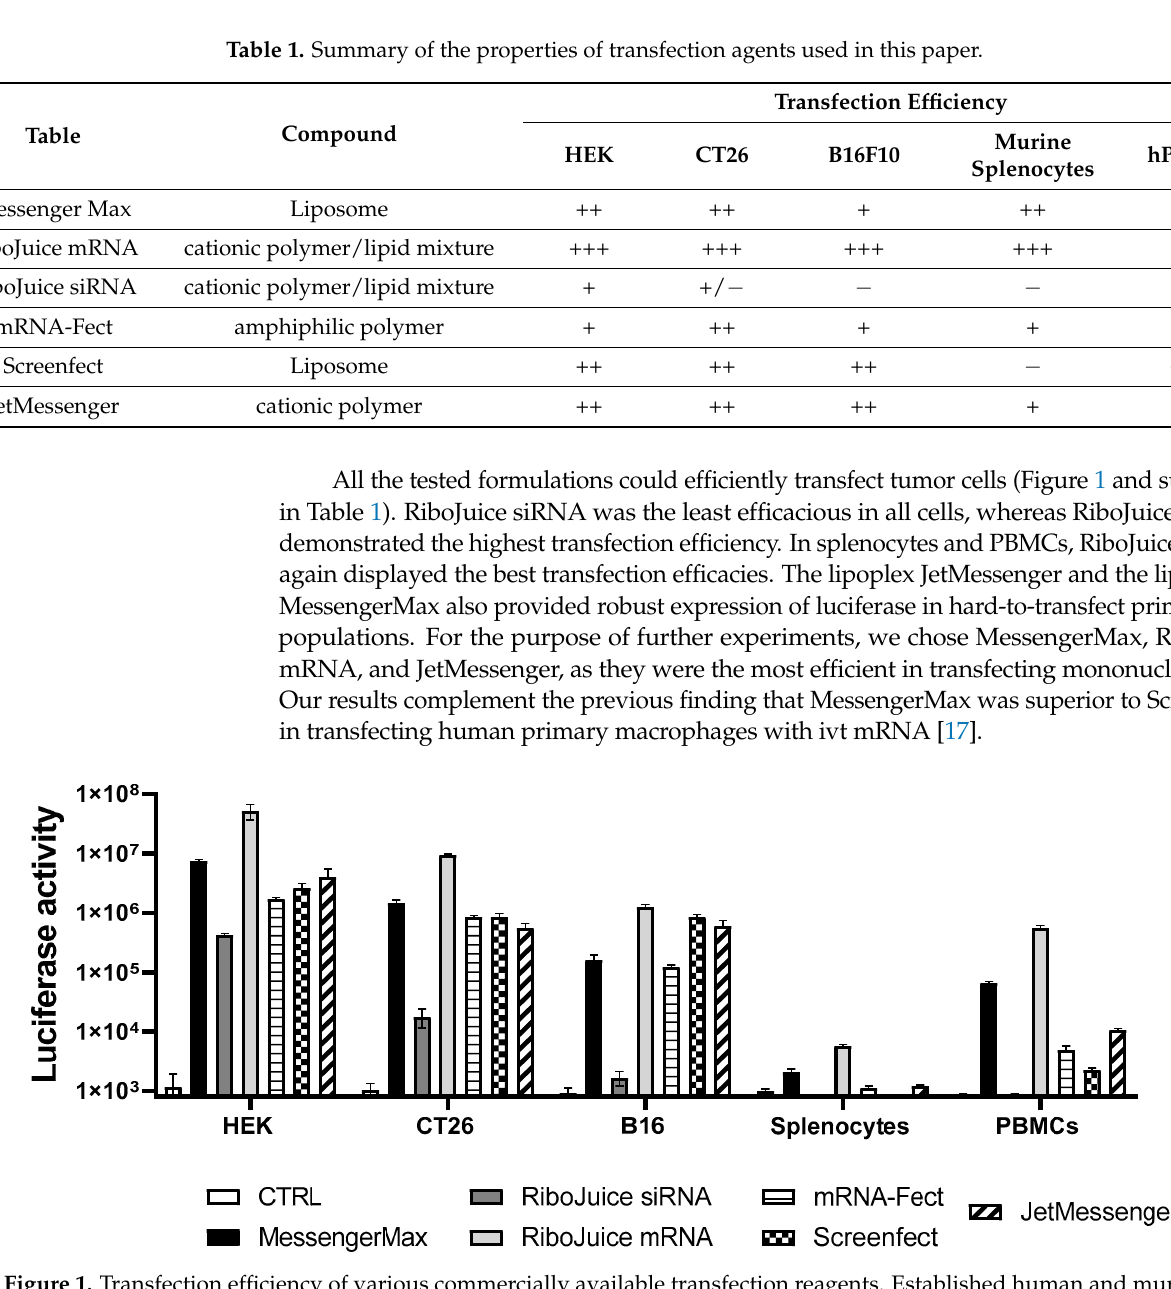
Table 1. Summary of the properties of transfection agents used in this paper.